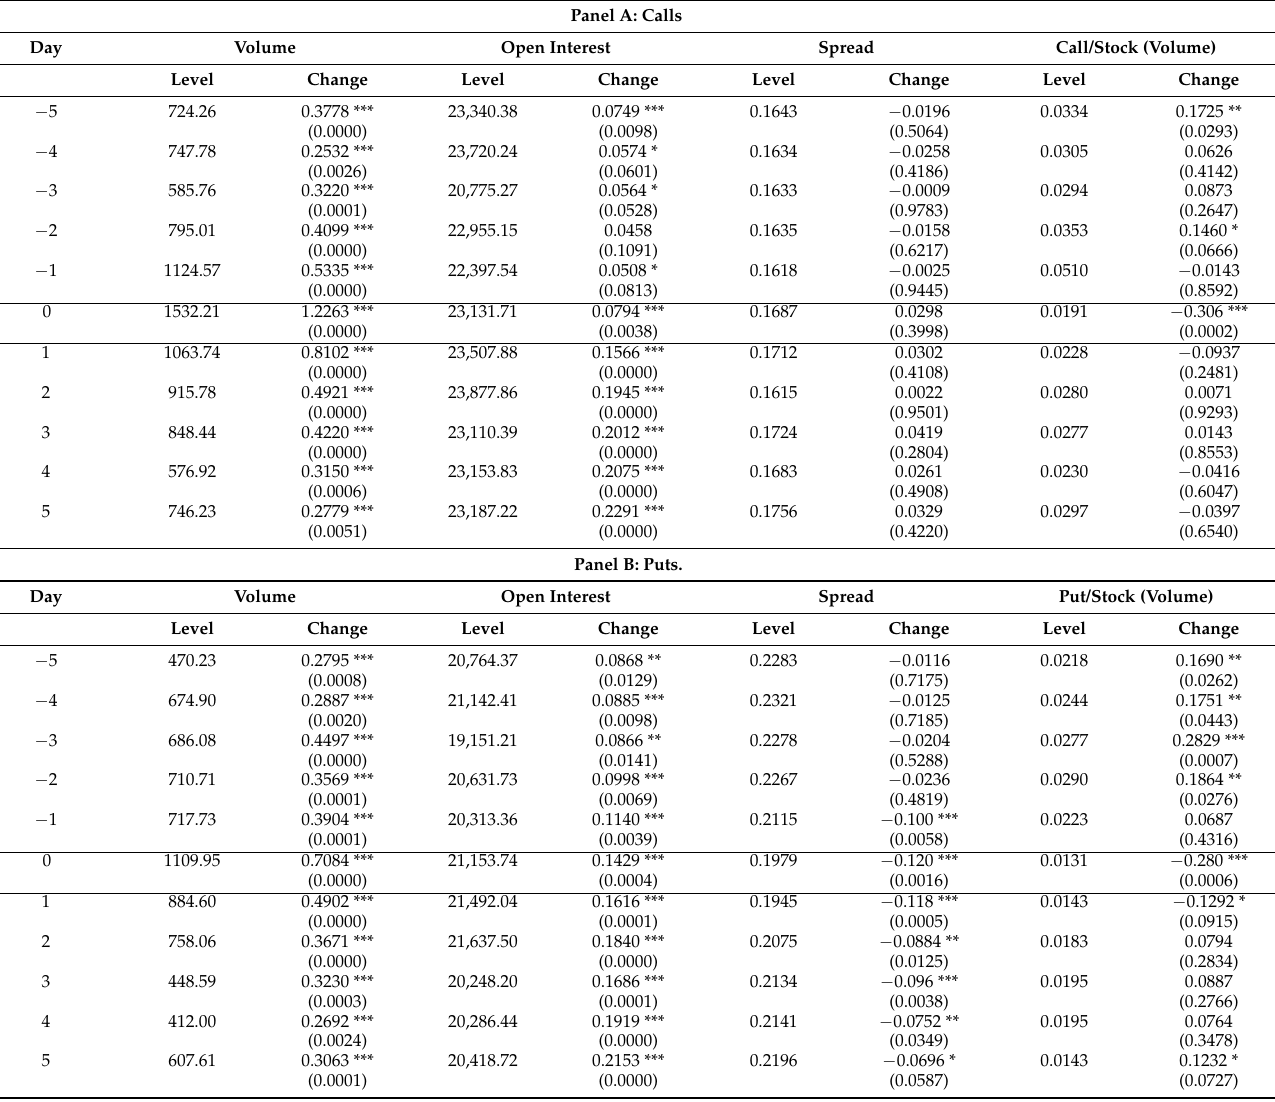
Table 2. Change in volume, open interest, and spread for calls, puts around SEO